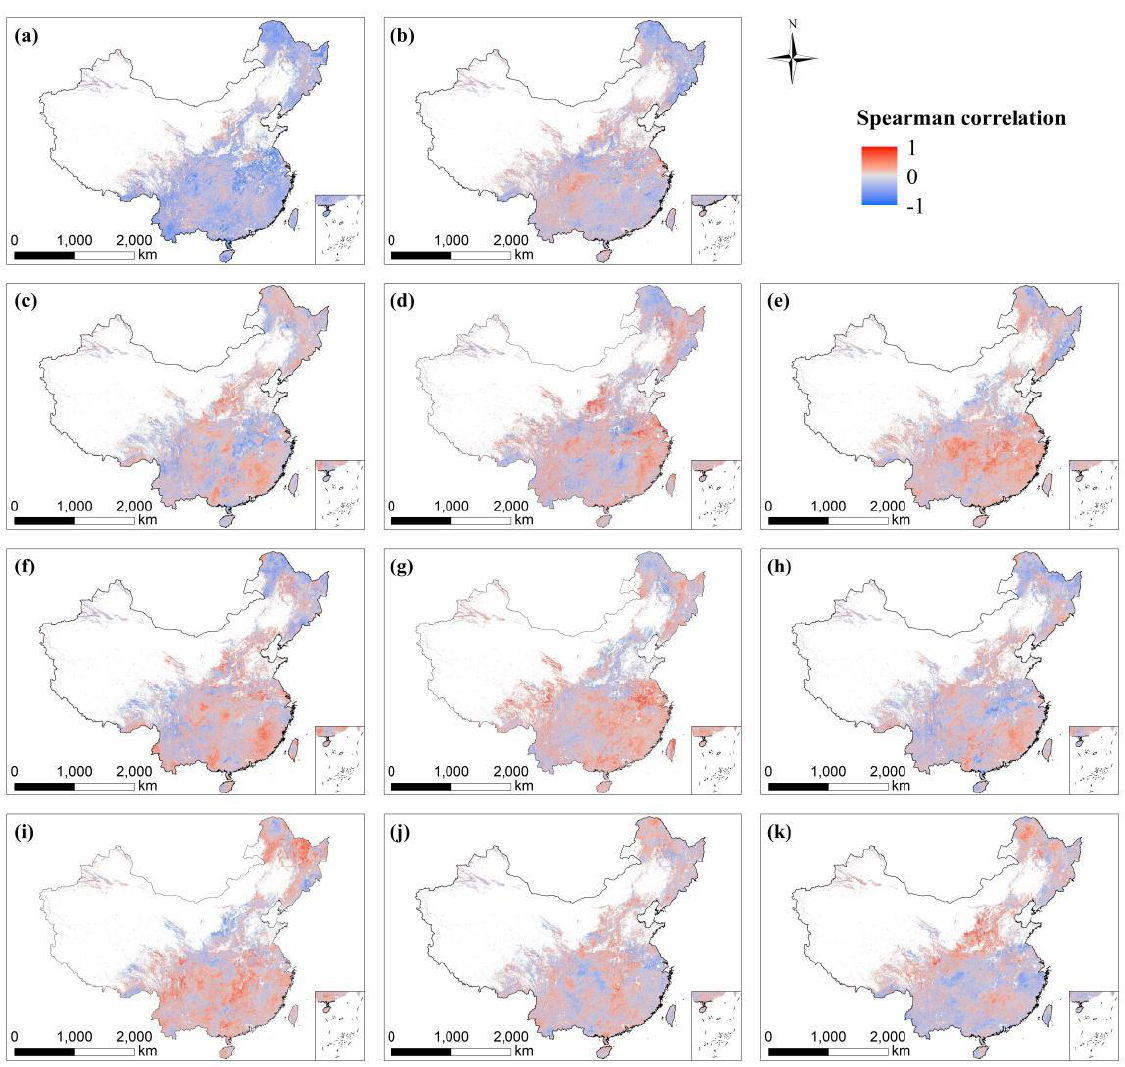
Figure 9. Spatial correlations between forest vulnerability and ( a ) AGB, ( b ) LAI, ( c ) P cum , ( d ) T avg , ( e ) T max , ( f ) avg aP cum , ( g ) avg aT avg , ( h ) PDSI, ( i ) SRad, ( j ) WS, and ( k ) MI during 2001 – 2020.